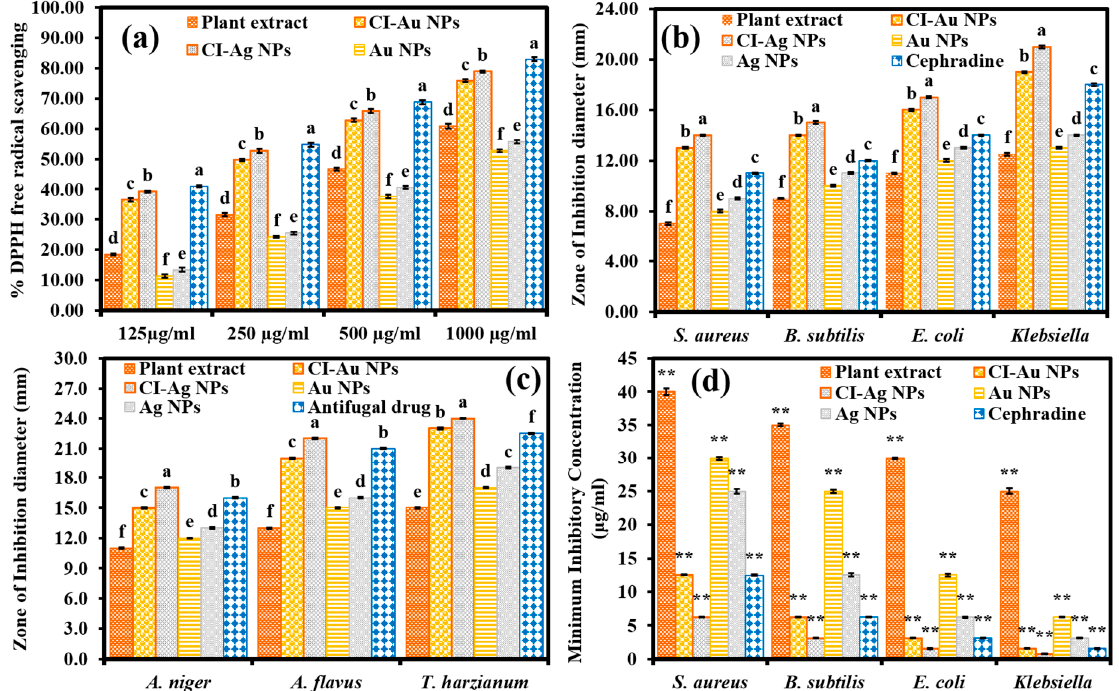
Figure 6. ( a ) Antioxidant, ( b ) antibacterial, ( c ) antimycotic activities, and ( d ) MICs results of green synthesized CI-Au NPs, and CI-Ag NPs in comparison to C. inerme leaves extract, Au NPs, Ag NPs, and standards (BHT, antibacterial and antifungal drugs). (Note; Tukey based heterogeneous lower-case letters represent significant statistical pairs). (** p < 0.01).